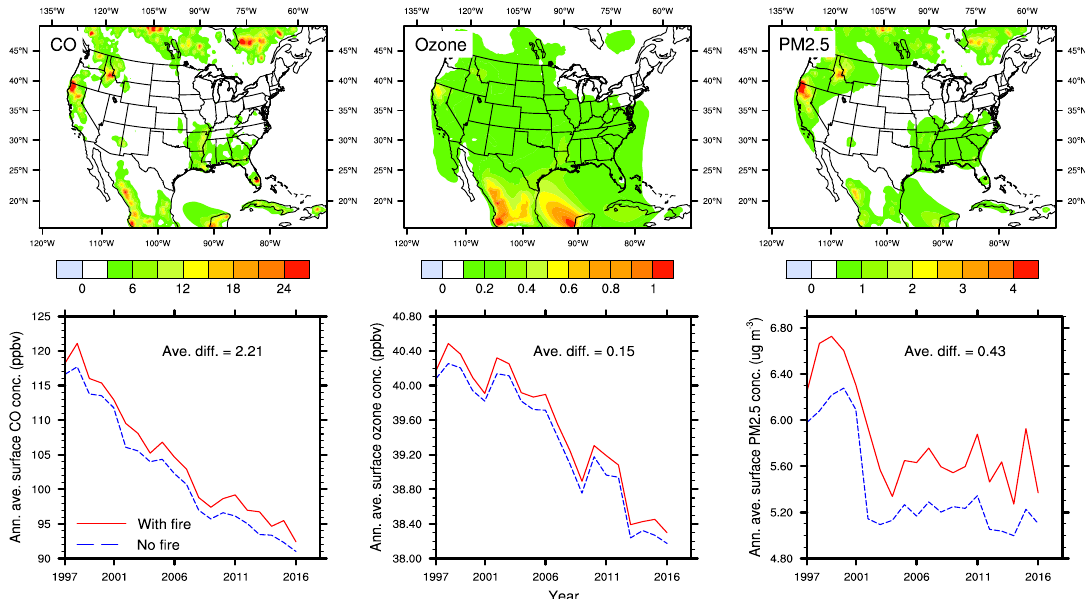
Figure 5. Top panels: spatial distribution of fire contributions to 20-year average surface air quality of CO (ppbv), O 3 (ppbv), and PM 2.5 ( µ g m − 3 ); bottom panels: evolutions of annual average surface concentrations of CO, O 3 , and PM 2.5 from